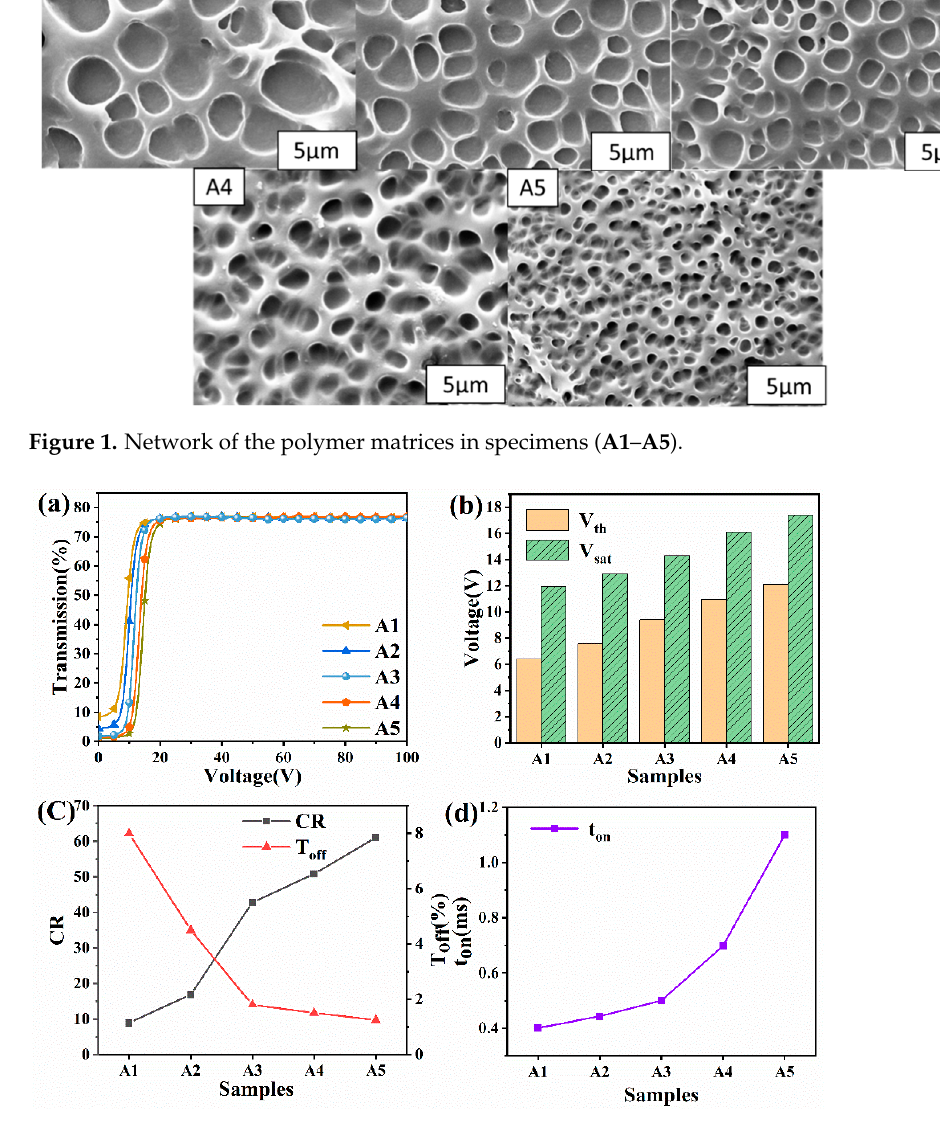
Figure 2. ( a ) Reliance of the transmi tt ance of specimens A1–A5 upon that applied electric fi eld (100 Hz); ( b ) Saturation voltage and threshold voltage of specimens A1–A5; ( c ) Contrast ratio and o ff - state transmi tt ance of specimens A1–A5; ( d ) Reaction speed of specimens